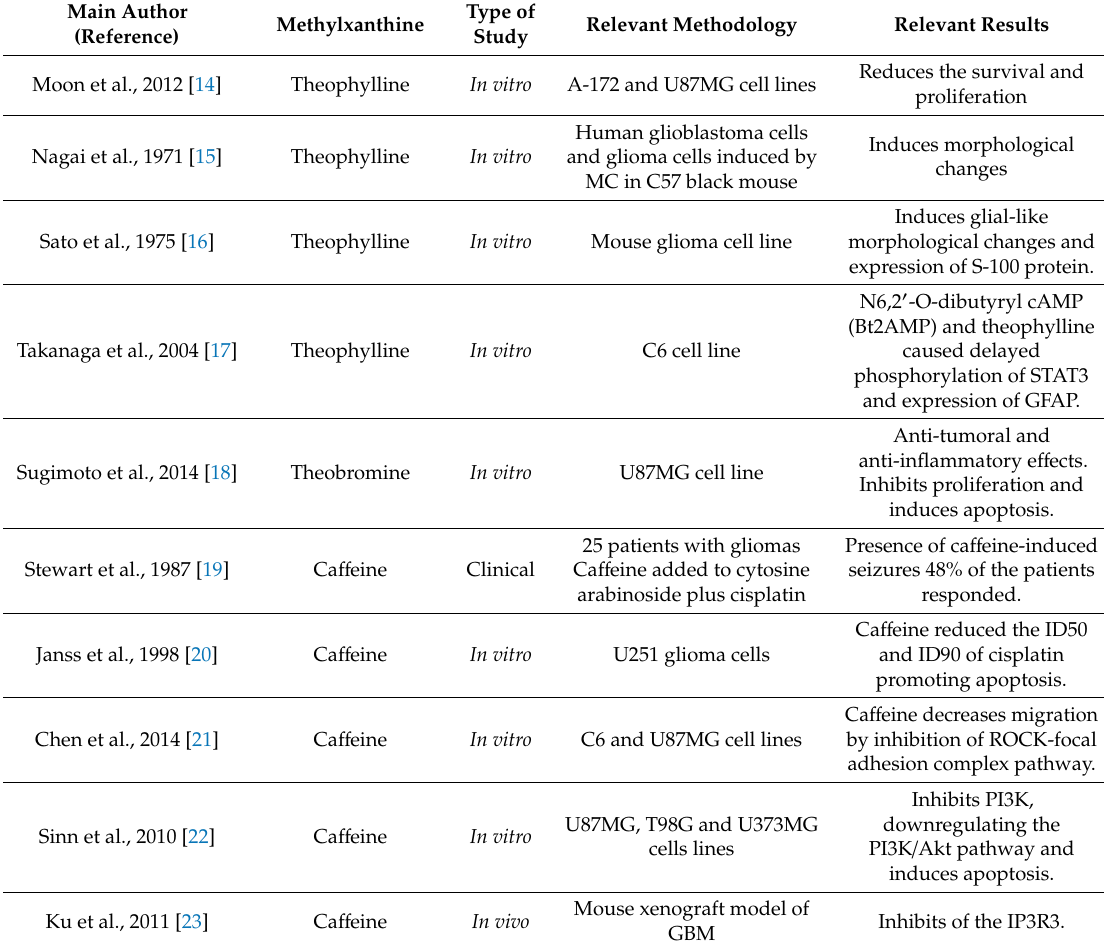
Table 1. E ff ect of methylxanthines in